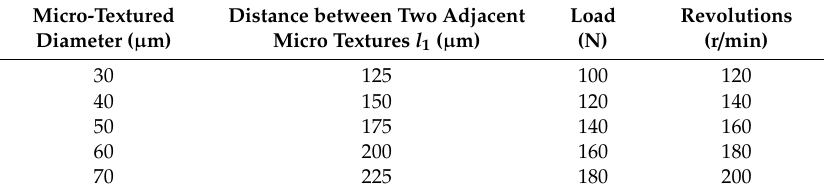
Figure 1. High-speed friction and wear testing machine. Table 4. Orthogonal horizontal factors in friction and wear tests.